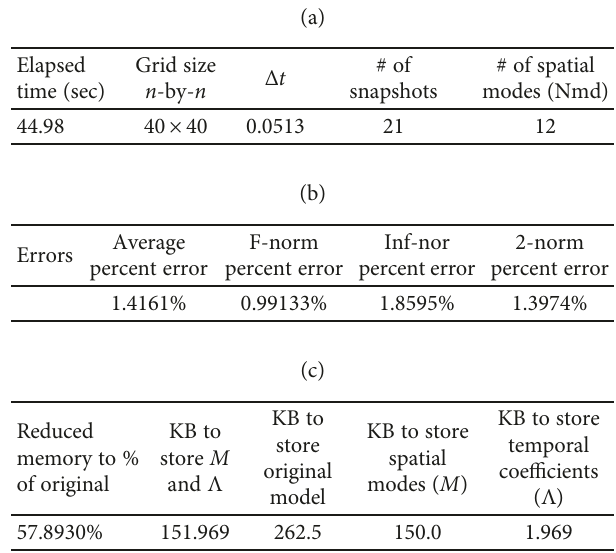
= 12 ). Table 2: Algorithm 2 results (40 × 40 grid, N = 21 , N md